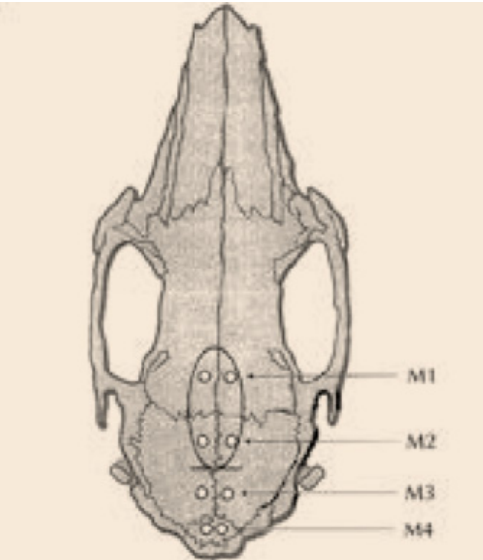
FIGURE 1 - Location of amalgam markers and spring. M1. Marker 1: 5mm from the mid line (to the right M2. Marker 2: 5mm from the mid line (to the right M3. Marker 3: 5mm from the mid line (to the right